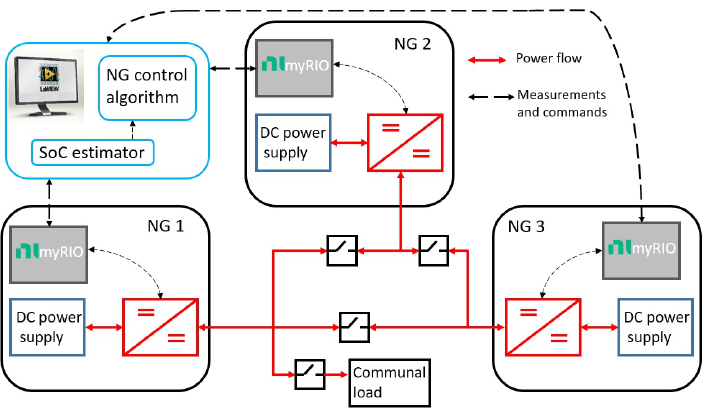
Figure 18. Schematic of the lab test bench.